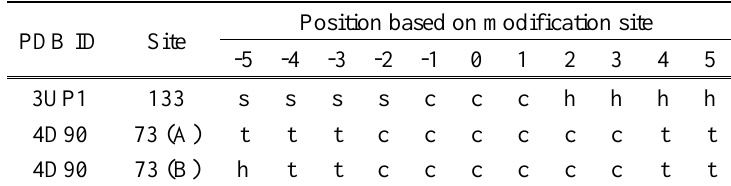
Secondary structure propensities around GalNAc modification sites h: Helix, s: Strand, t: Turn and c: Coil